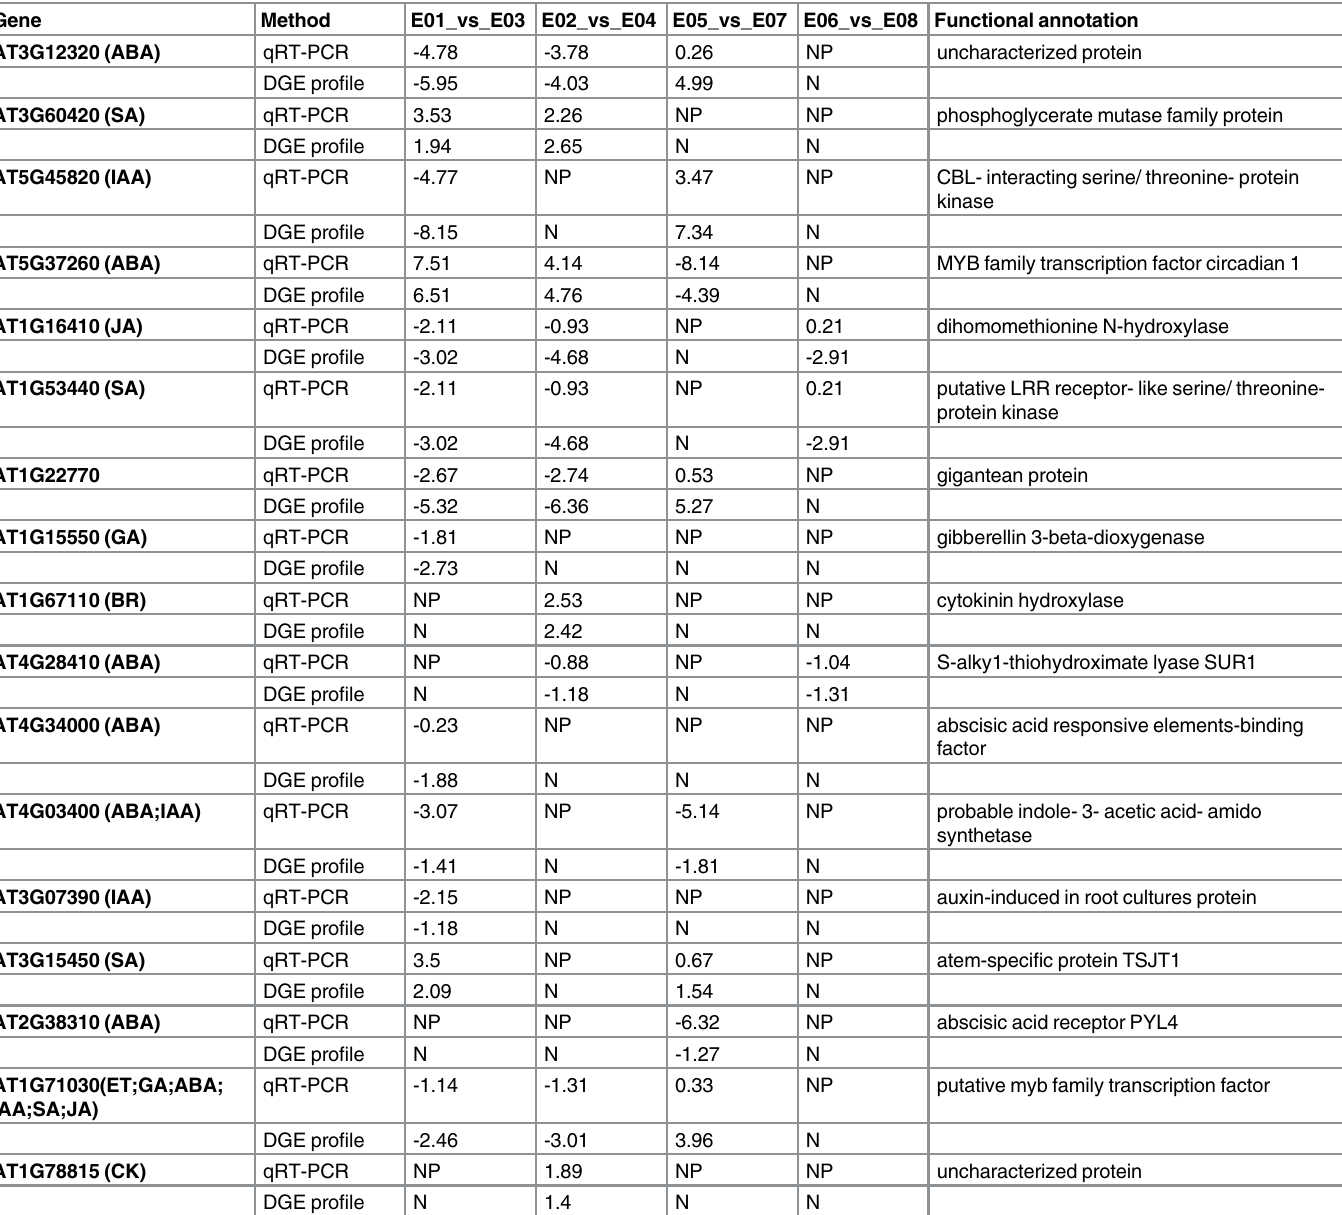
Table 3. Verification of DGE-seq results by